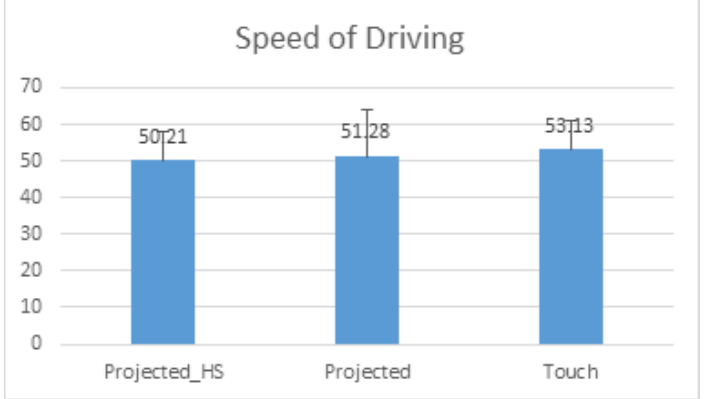
Figure 27. Comparing Driving Performance in terms of the average speed of driving.